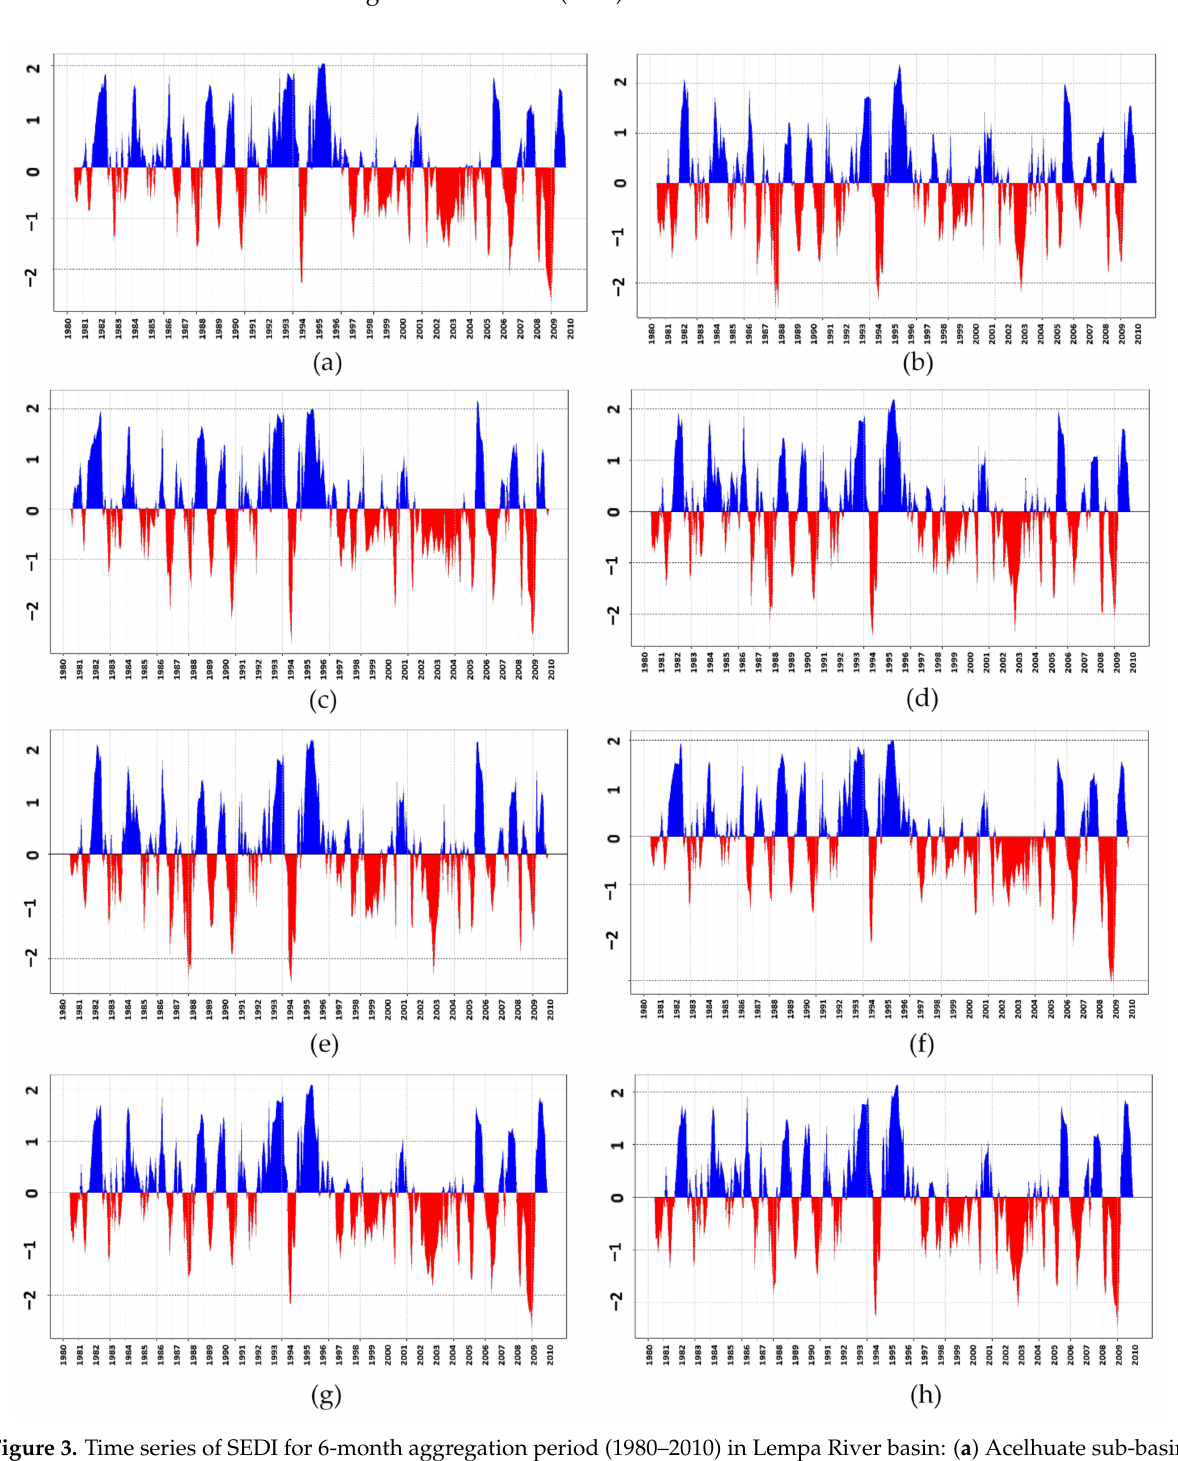
Figure 3. Time series of SEDI for 6-month aggregation period (1980–2010) in Lempa River basin: ( a ) Acelhuate sub-basin; ( b ) Guajillo sub-basin; ( c ) Lempa1 sub-basin; ( d ) Lempa2 sub-basin; ( e ) Lempa3 sub-basin; ( f ) SS3 sub-basin; ( g ) SS6 sub-basin; and ( h ) Suquioyo